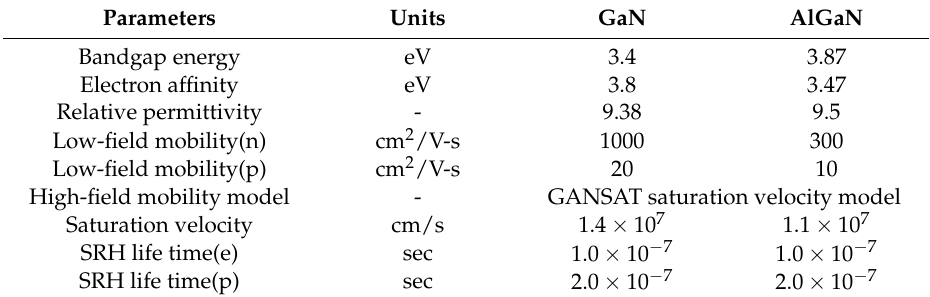
Table 2. Simulation model parameters. (Gate metal work function, Φ M = 5.0 eV).